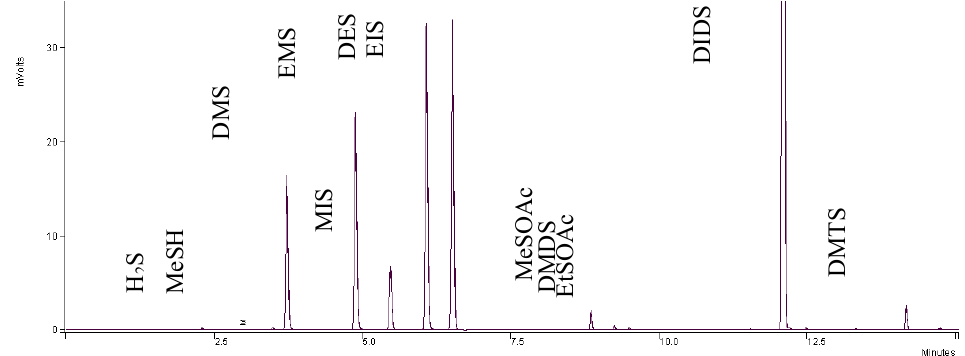
Figure 6. Representative GC-PFPD chromatogram of wine (cabernet sauvignon).